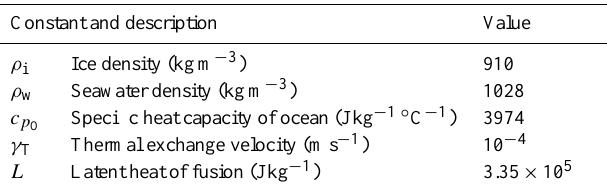
Table 2. Physical parameters for the sub-shelf melt parameterisa-